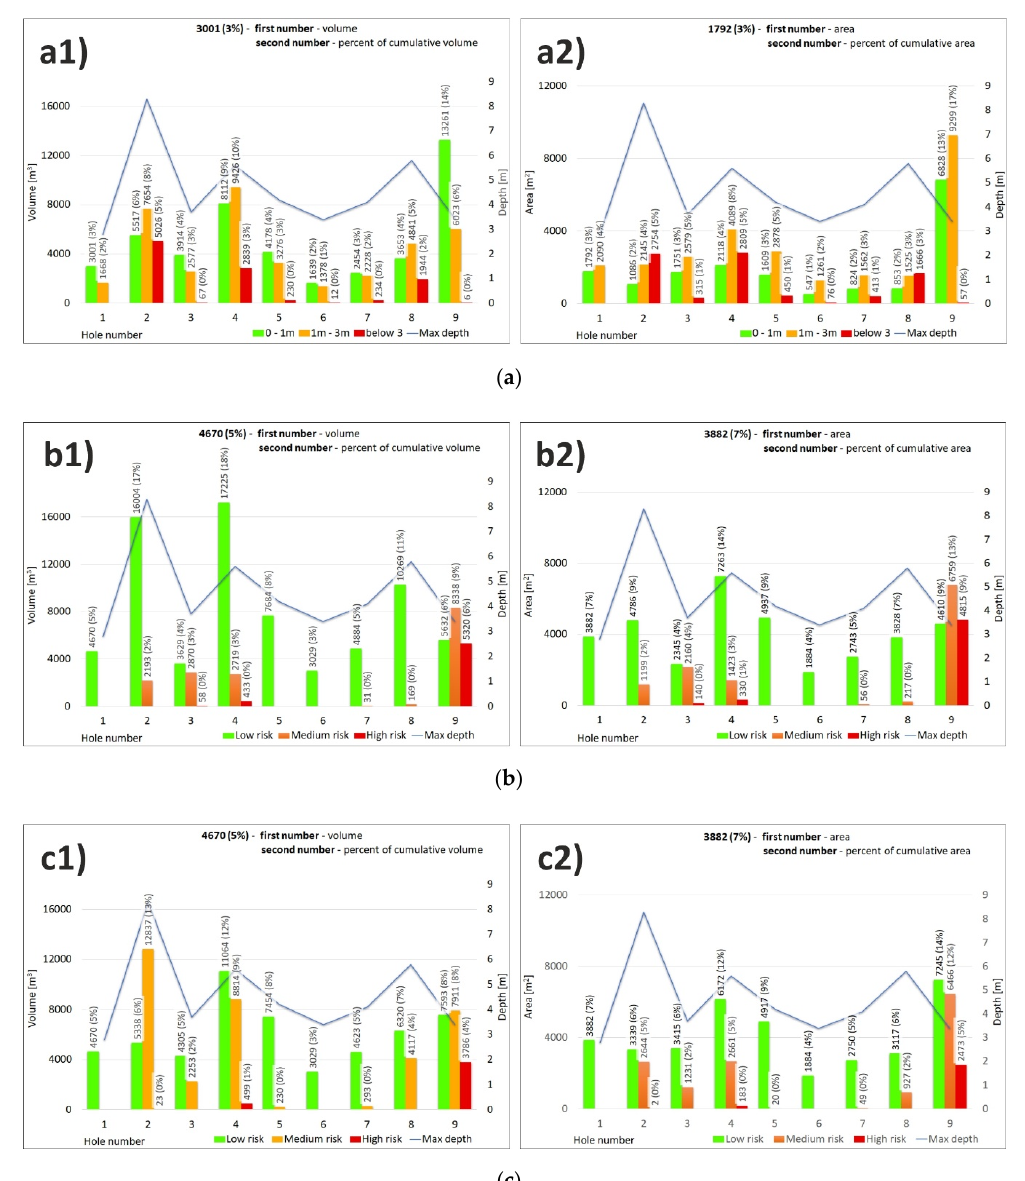
Figure 11. Quantification of risk categories in the special river bottom hazard map for every pothole ( a ) classification by factor of pothole depth, ( b ) classification by factor of distance from structure of dam and threshold, ( c ) final map classification by combination of these two factors: ( a1 , b1 , c1 ), volume (m 3 ), ( a2 , b2 , c2 ) area (m 2 ).